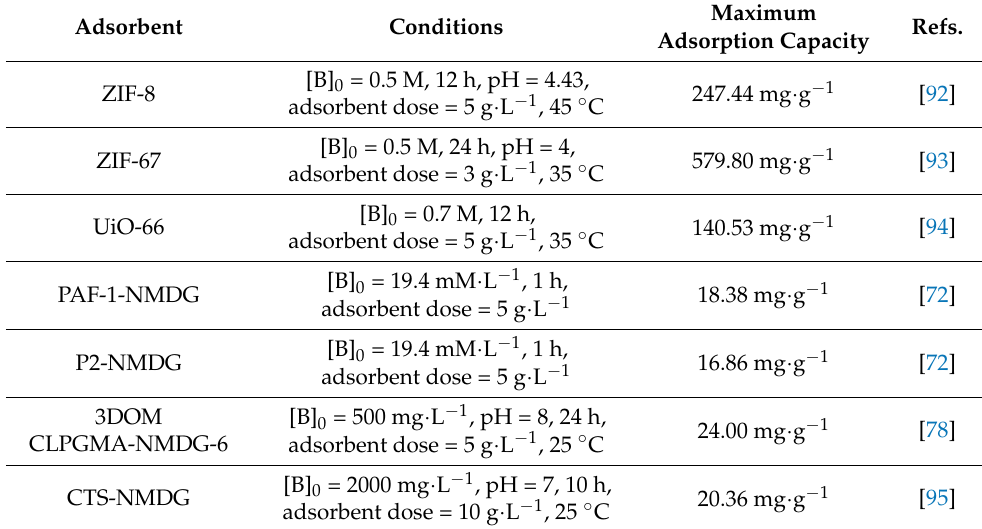
Table 13. Boron removal performances of POPs